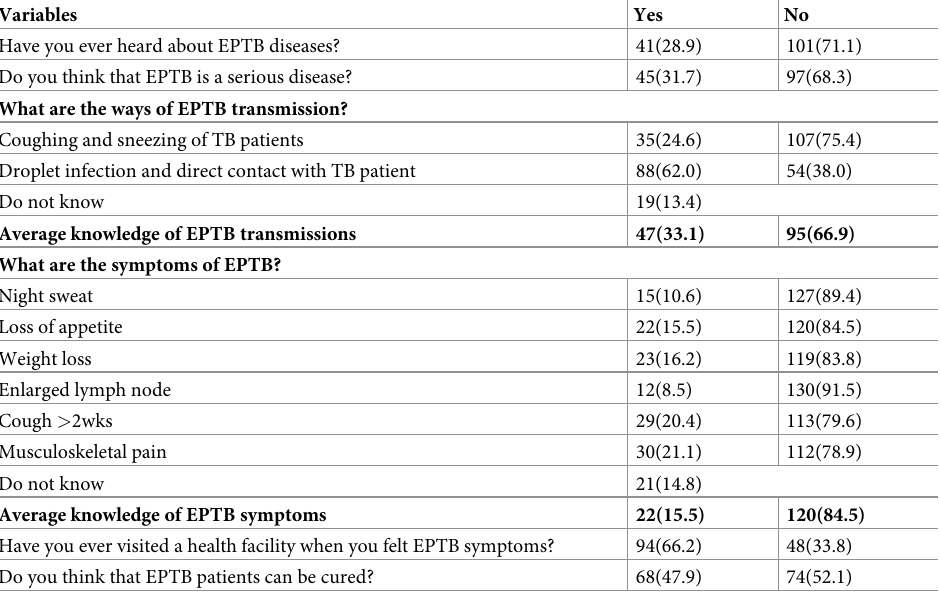
Table 3. Respondents’ knowledge of EPTB at public health facilities of North Shewa zone, Ethiopia, April 2021.